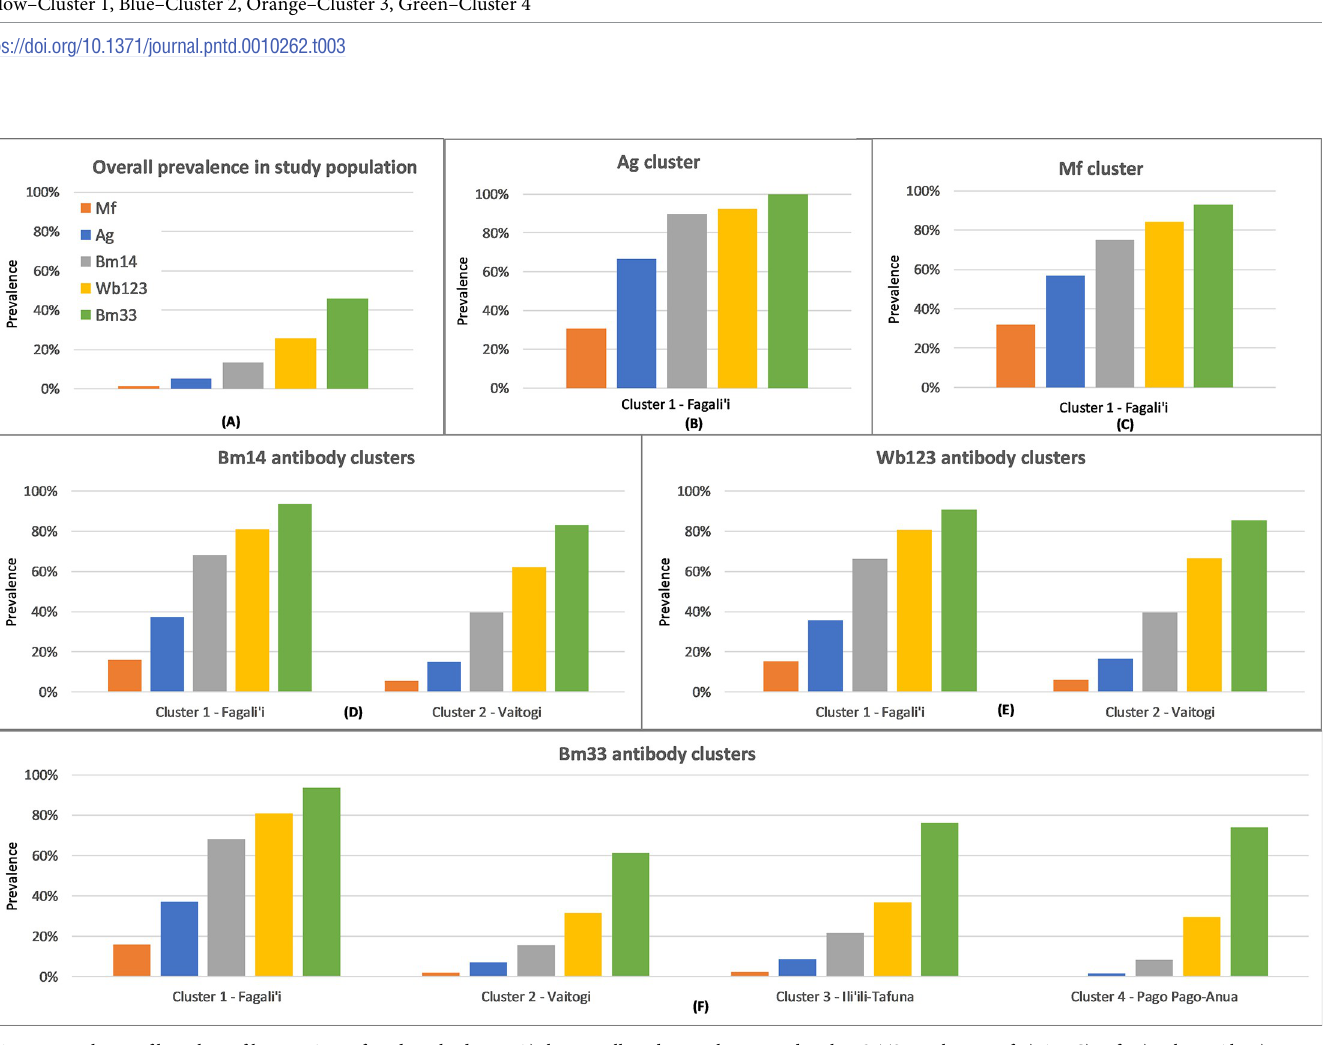
Fig 8. Prevalence of lymphatic filariasis Ag, Mf, and antibodies in A) the overall study population, and within SaTScan clusters of B) Ag, C) Mf, D) Wb123 Ab, E) Bm14 Ab, and F) Bm33 Ab, American Samoa 2016.